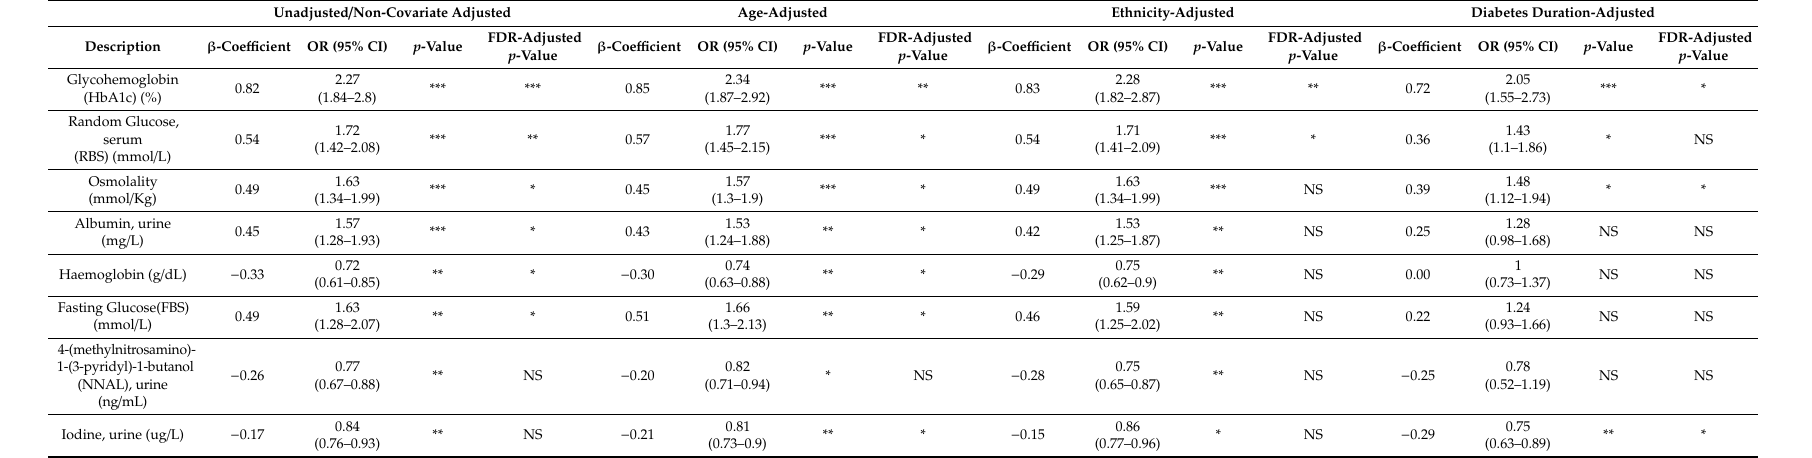
Table 3. Laboratory variables associated with retinopathy in individuals with